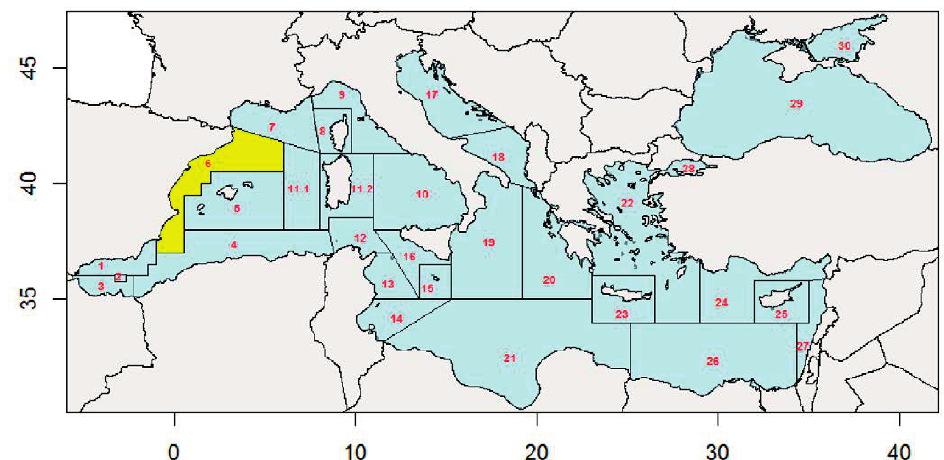
Fig. 1. – Study area: GSA 6, northern Spain. Geographical subareas as established by the General Fisheries Commission for the Mediterranean (GFCM).